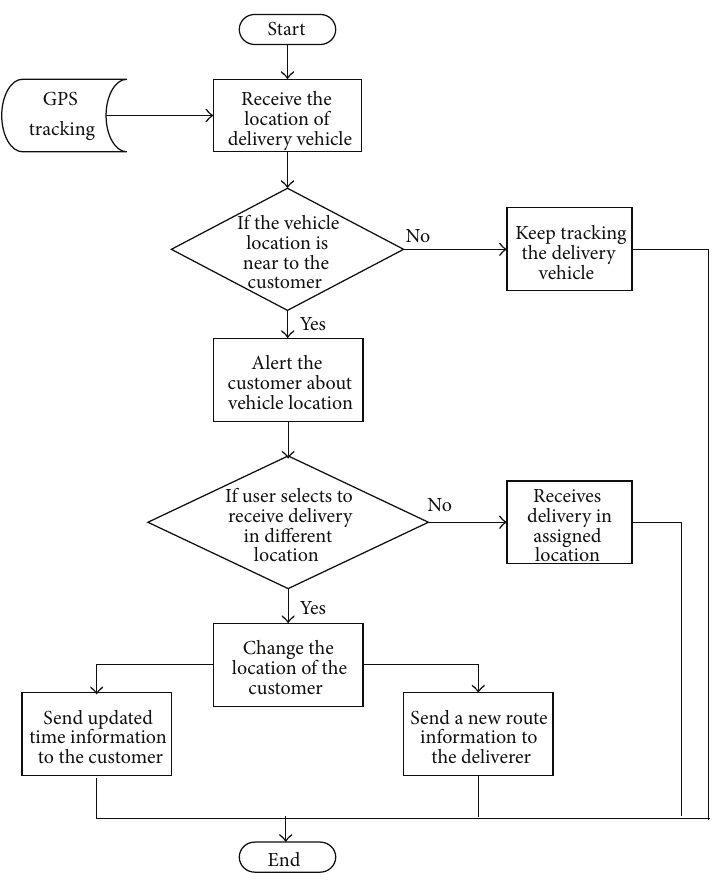
Figure 9: Location change request scenario from customer.